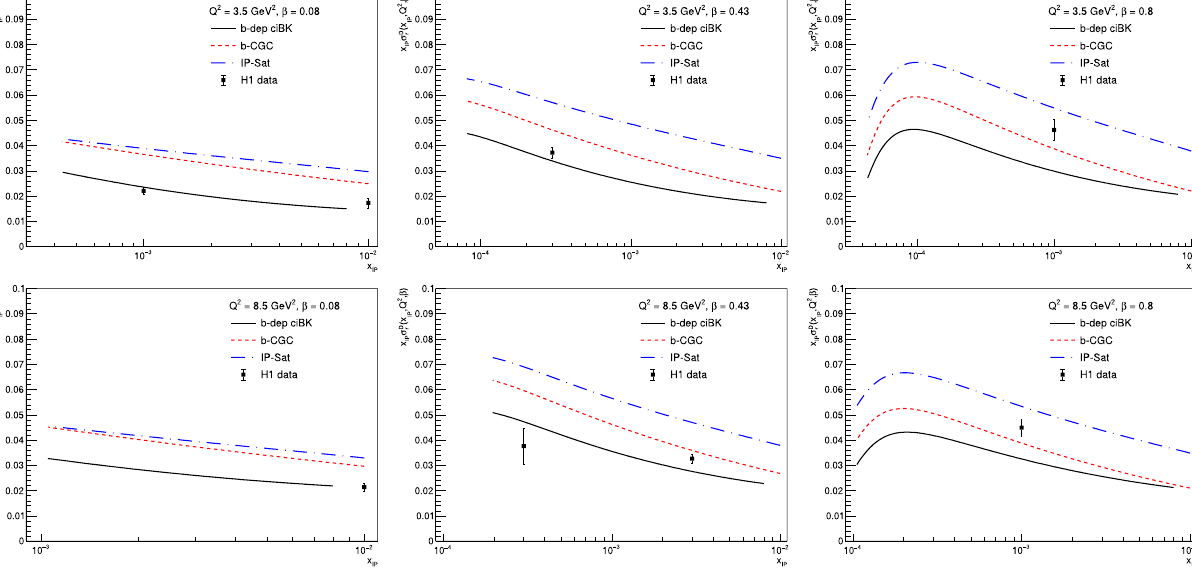
Fig. 7 Predictions for the x IP -dependence of the reduced diffractive cross section σ D ( 3 ) r ( x IP ,β, Q 2 ) at different combinations of the photon virtuality and β , considering the b-CGC, IP-Sat, and b-dep ciBK models for the dipole-proton scattering amplitude. Data from H1 are presented for comparison